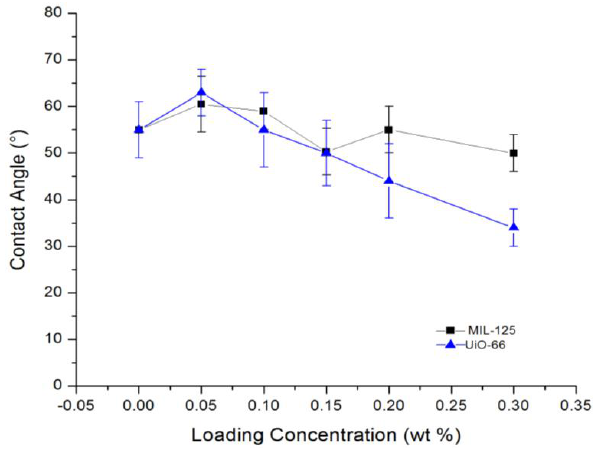
Figure 6. Pure water contact angle with the modified thin film nanocomposite (TFN) membranes surface.